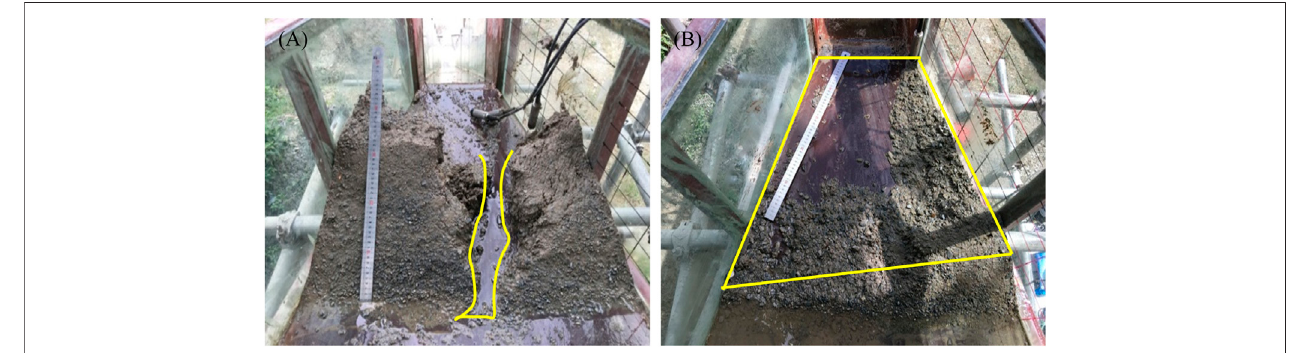
TABLE 2 | Summary of experimental results.